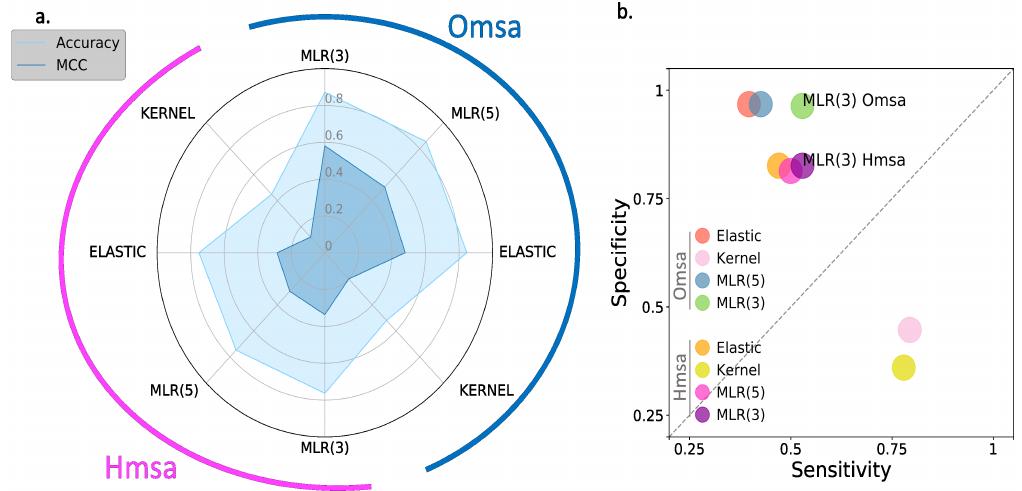
Figure 6. Performances of endophenotype-based pathogenicity predictions. BRCA1 case. Using functionality thresholds (see Material and Methods), we transformed the endophenotype estimates into benign/pathogenic predictions. The success rate of these pathogenicity predictions is described using four standard parameters: ( a ) Accuracy/MCC and ( b ) sensitivity/specificity. In ( a ), the half-circles external to the radar plot identify the results obtained with different multiple sequence alignments: Omsa (blue) and Hmsa (pink). In ( b ), we use different colors to establish this difference. For reference, we locate the MLR model obtained using three features only.